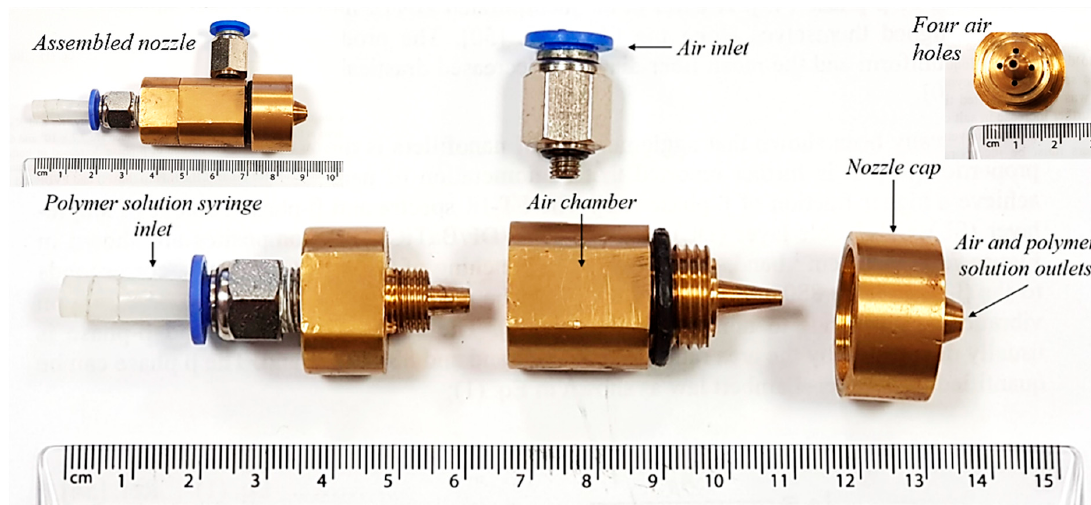
Figure 2. Various parts of the fabricated nozzle with four air holes through air chamber shown in the top right corner and assembled nozzle shown in the top left corner.